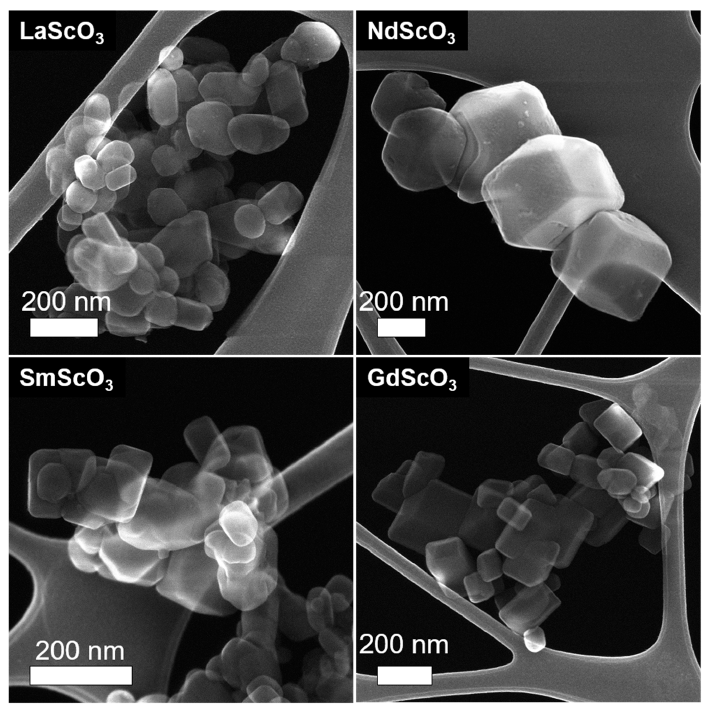
Figure 4. SE images of REScO 3 (RE = La, Nd, Sm, Gd) produced using the two-step heat treatment at 450 °C for 2 days and then 300 °C for 1 day. Smaller particles were produced because the high- temperature step had a more negative Δ G rxn , which led to a higher nucleation rate. The particles are more faceted because the low-temperature step had a less negative Δ G rxn , so step-flow terrace growth dominated. Note that SE images do not show the surfaces of REScO 3 as clearly as other oxides do, as discussed in the text.